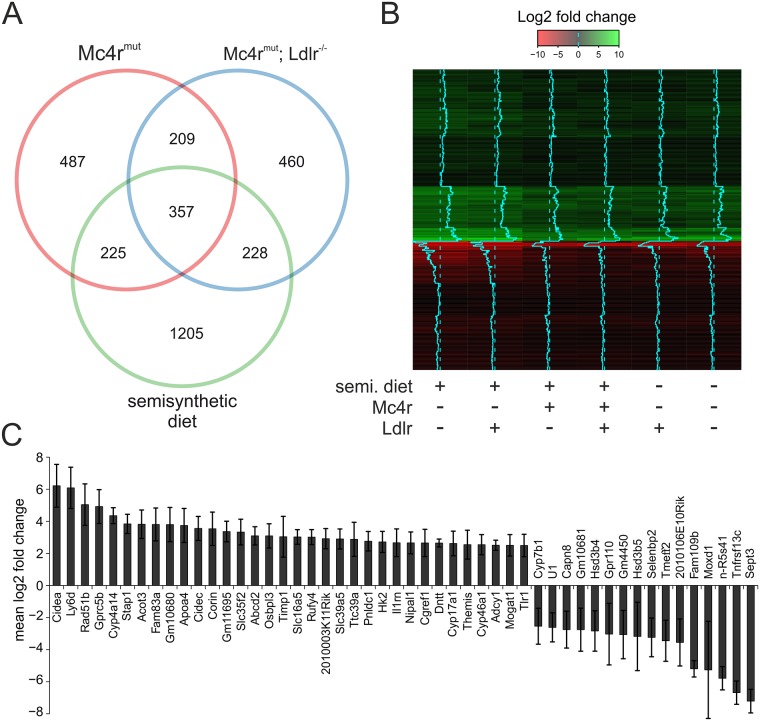
Common indicators of genetically and diet-induced NAFLD.(A) The numbers of differentially expressed genes in the liver of Mc4rmut
(red circle), Mc4rmut;Ldlr-/- (blue circle) mice under regular chow and of wt mice under semisynthetic diet (green circle) were compared to the wt data set under regular chow (served as reference) and plotted as Venn diagram. The total numbers of significantly up- and down-regulated genes (p < 0.05) are given in S3 Table. (B) The expression profiles of the 357 overlapping genes from the Venn diagram (Fig 2A) compared to the wt under regular chow (served as reference) for all mouse groups investigated are given as log2 fold change. The log2 fold change is color-coded with up- and down regulation of genes in green and red, respectively. Additionally, the blue trace in the middle of each lane gives the direction of quantitative changes by deviation from the dotted line (wt level under regular chow) to the right (up regulation) or to the left (down regulation). The genotypes and diets are given below the heat map (+ with, — without). (C) Average log2 fold change of the 50 strongest regulated genes that reached statistical significance across all differential expression analyses (p < 0.05).